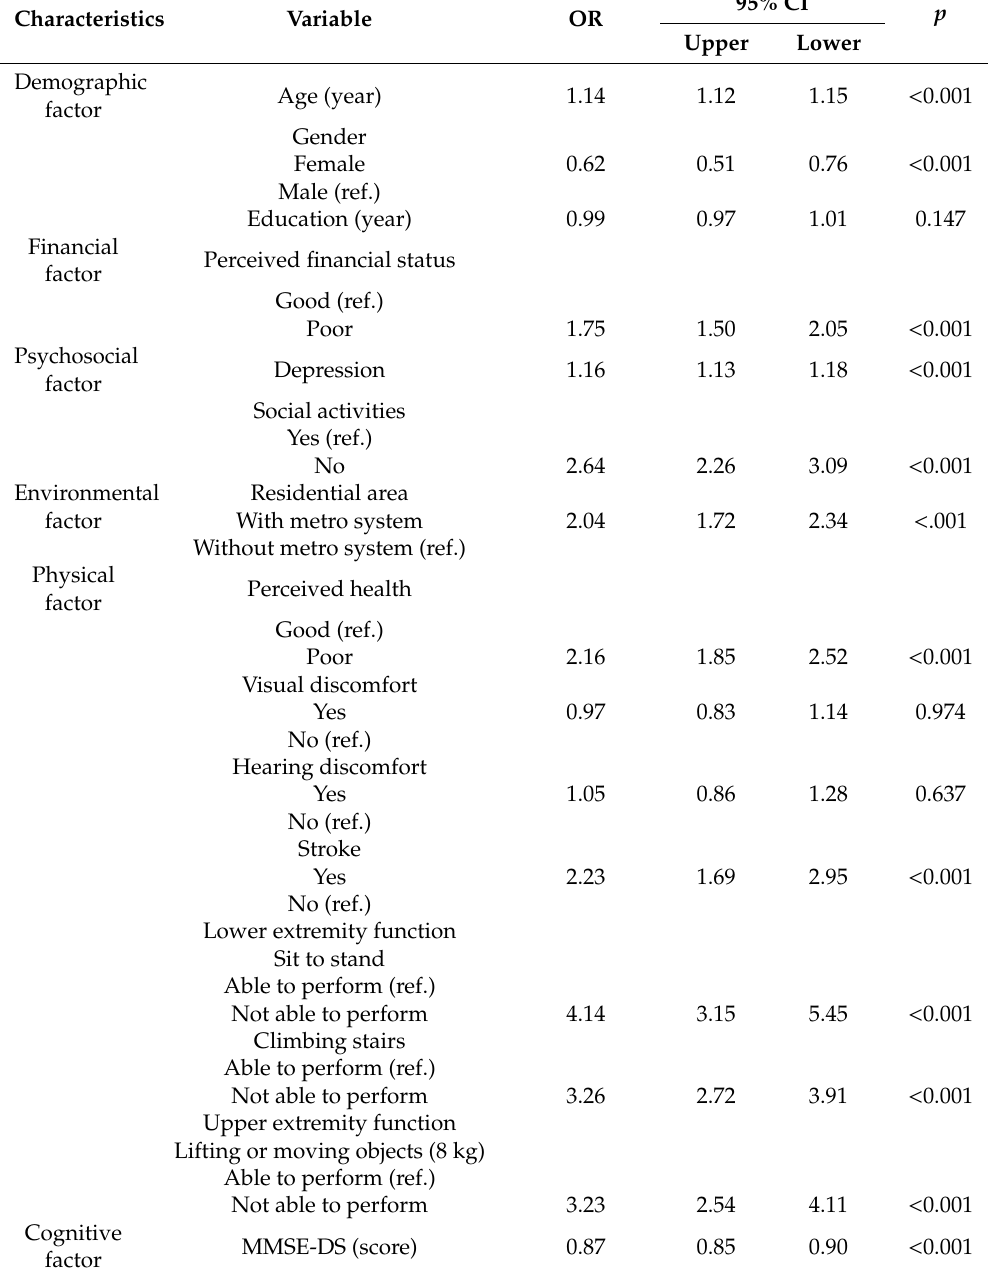
Table 2. Univariate logistic regression models for driving cessation ( N = 2970).